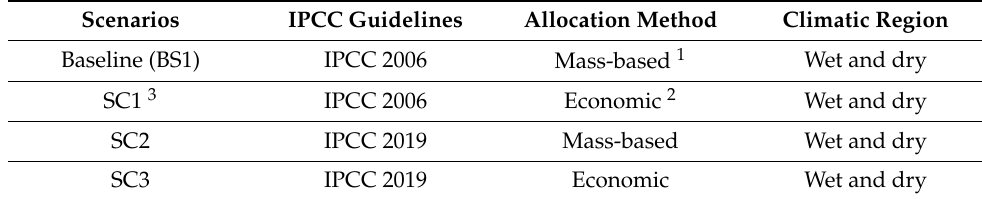
Table 4. Scenarios established for the sensitivity analysis of barley production. Scenarios IPCC Guidelines Allocation Method Climatic